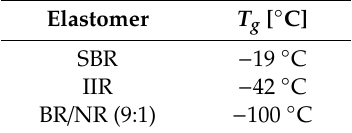
Table 4. Rubber compounds used for the interlayer in the armored laminates tested.